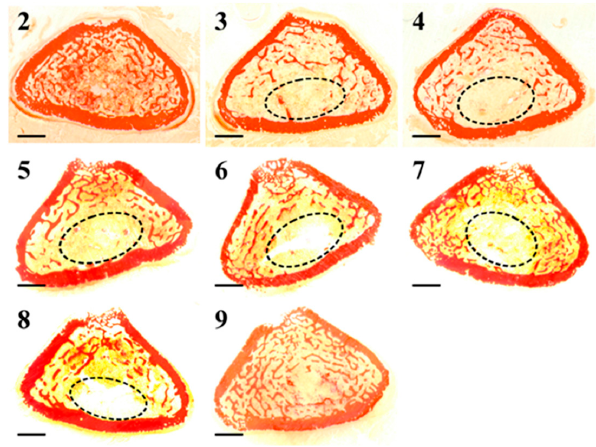
Figure 8. Scans of femoral distal metaphysis transversal sections of all animal groups (2–9). The encircled areas show rarefied bony trabeculae in the posterior portion of the femoral metaphyses. Scale bar: 1 mm.